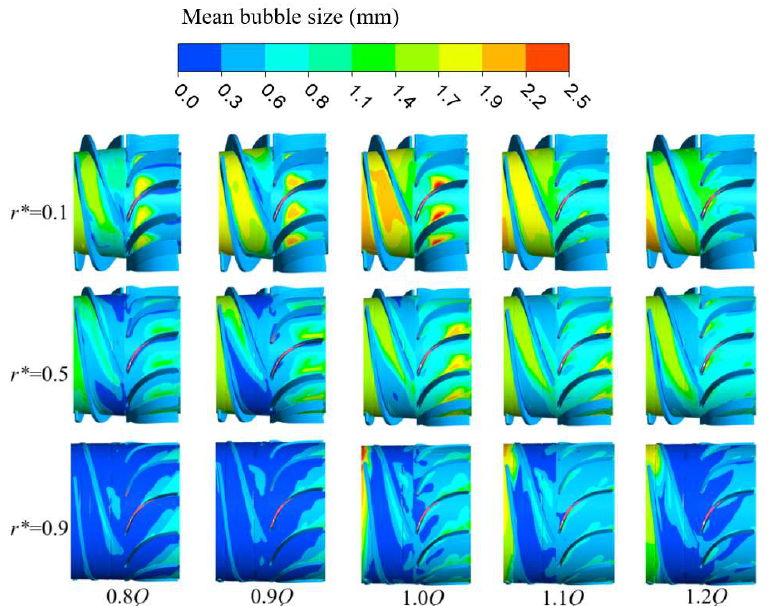
Figure 14. Bubble size distribution of gas–liquid two-phase media in the pressurization unit of the multiphase pump under different flow conditions.